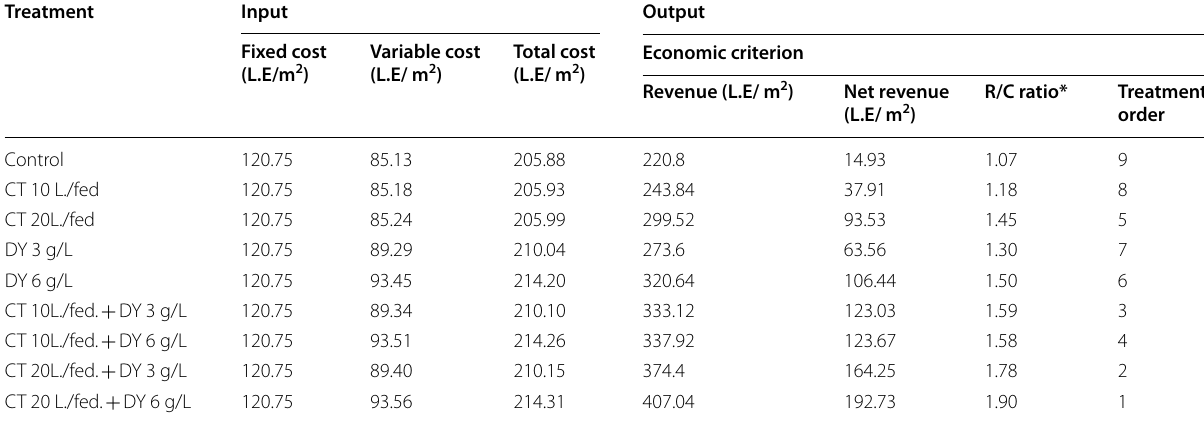
* R/C: Total Revenue /Total Cost